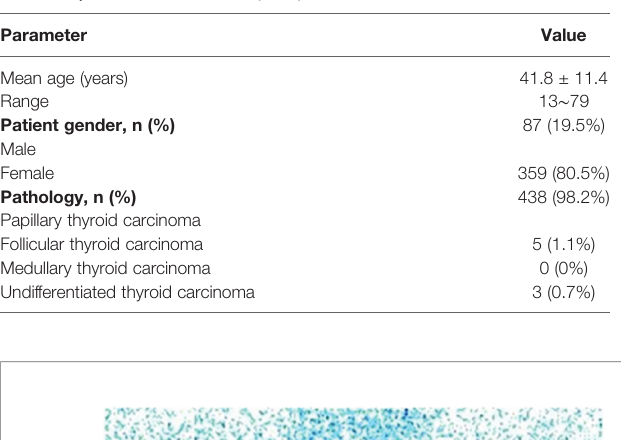
TABLE 1 | Characteristics of study subjects.